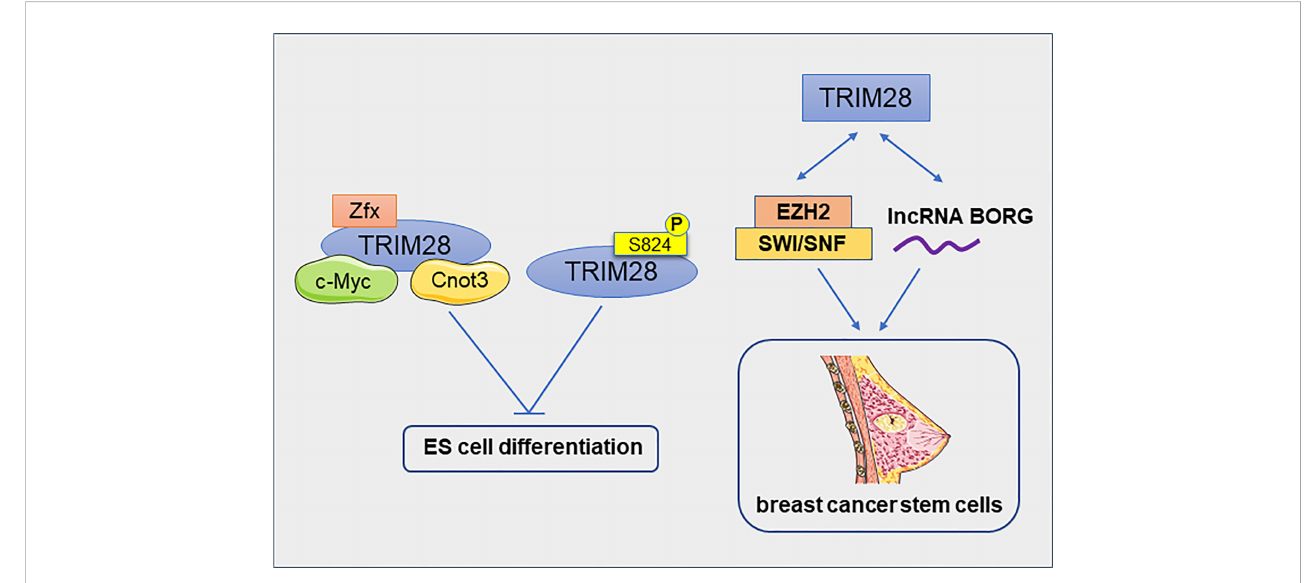
FIGURE 6 TRIM28 inhibits the differentiation of embryonic stem cells and promotes the enrichment and maintenance of breast cancer stem